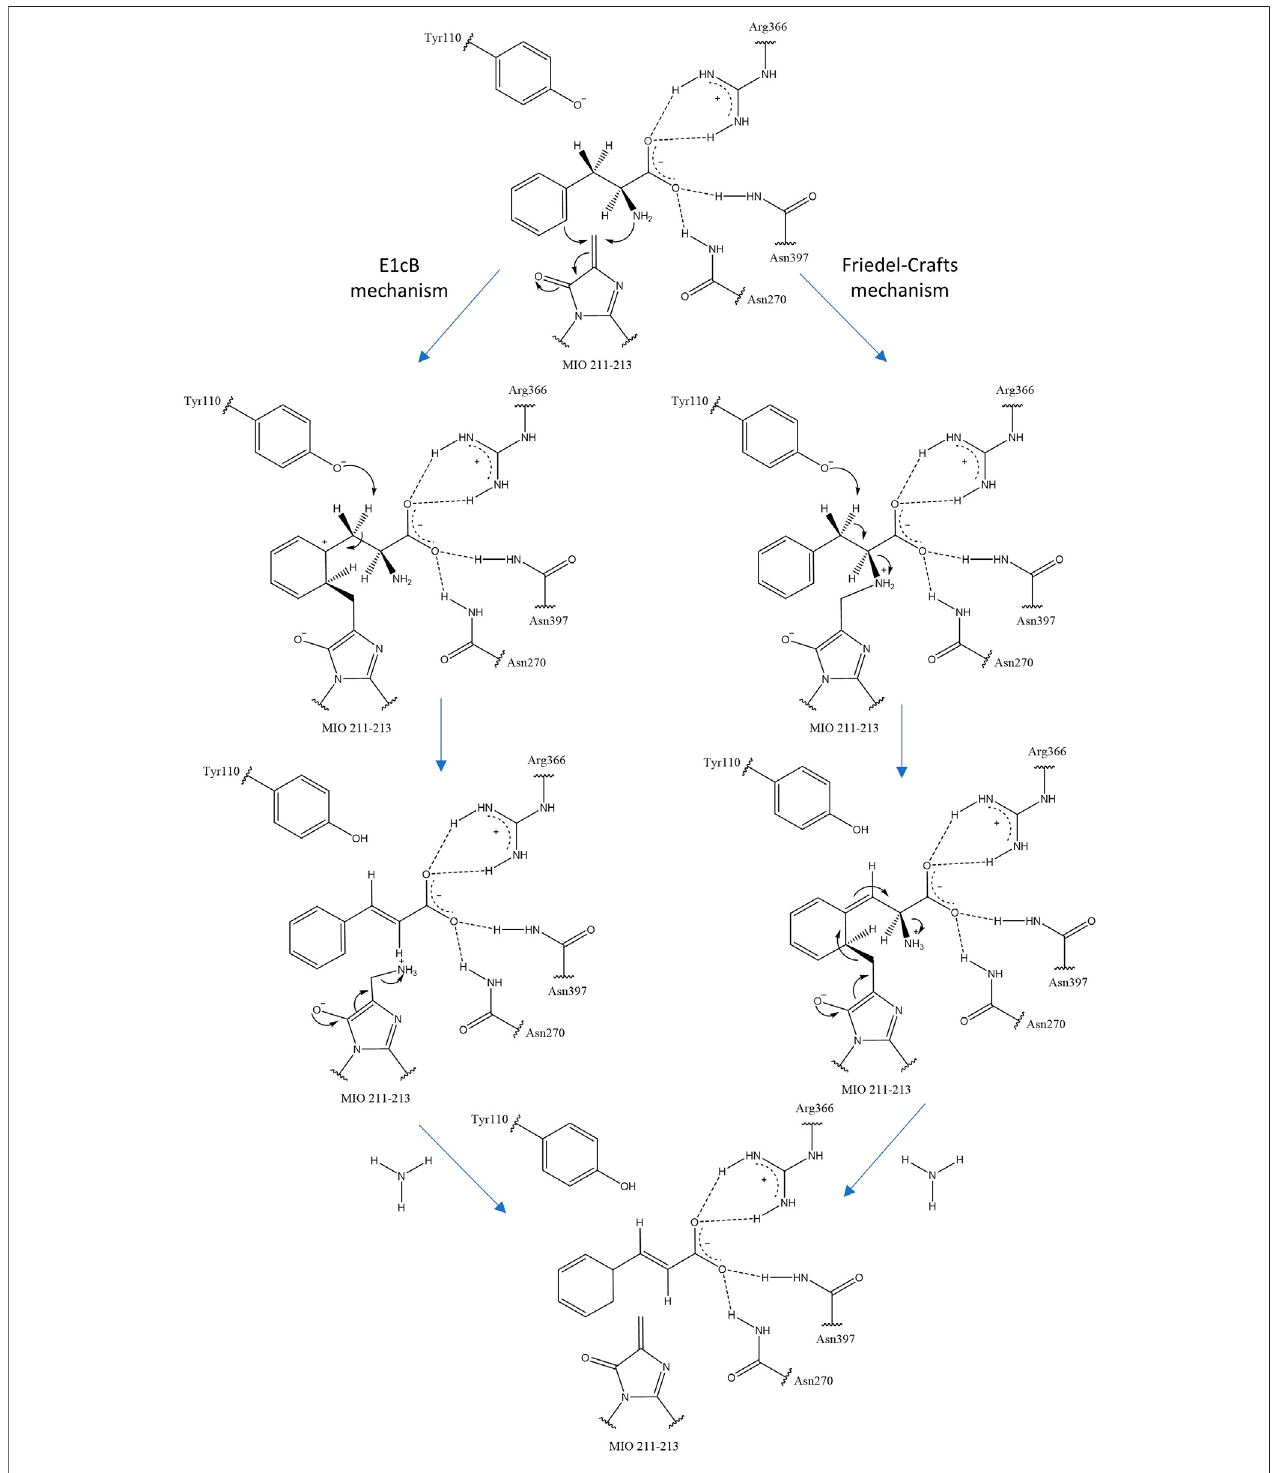
FIGURE 2 | Two proposals for ammonia elimination by R. toruloides PAL. The other residues help to orient and stabilize the carboxyl group of arylalanine amino acids.